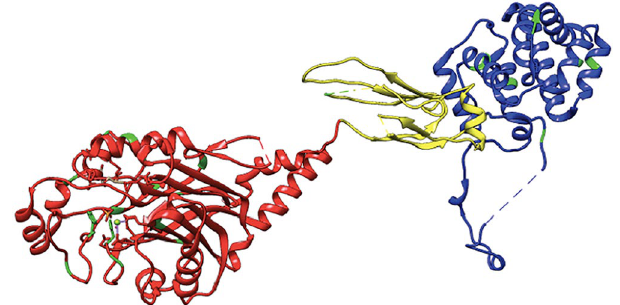
Figure 6. Structural analysis of mutations associated with congenital glaucoma in OCRL. Mutations in OCRL 5-phosphatase domain (red), ASH domain (yellow) and Rho-GAP like domain (blue) are mapped in the crystal structure of OCRL, showing majority of mutations (green) within the 5-phosphatase domain. The PDB accession numbers used were 4CMN (amino acids 215–560), 2QV2 (amino acids 564–901), and 3QBT (amino acids